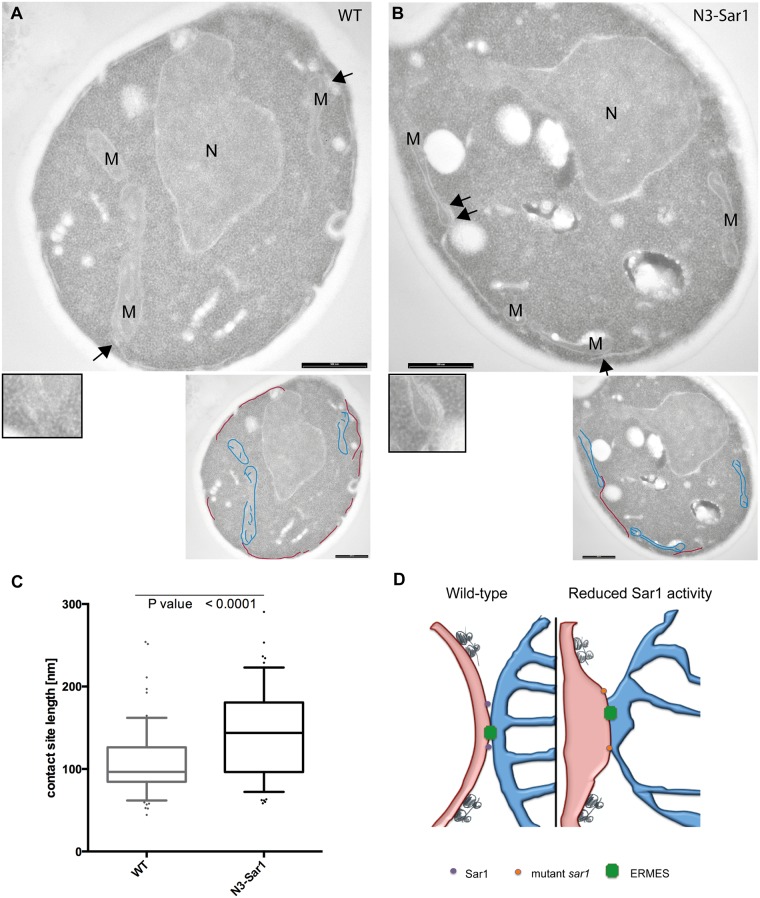
The N3-Sar1 mutant increases ER-mitochondria contacts site length.Transmission electron microscopy images of (A) wild type and (B) N3-sar1. The bars in (A) and (B) correspond to 1 μm. N: nucleus; M: mitochondria. Arrows point to regions of ER-mitochondria contacts. The insets display a 2x magnification of a region of interest. Relevant ER membranes and mitochondria were traced in red and blue, respectively, in the smaller images. (C) Quantification of the phenotype presented in (A) and (B). > 60 contacts were measured/genotype from two independent embeddings. An unpaired, two tailed T-test was used for statistical analysis. The whiskers represent 10–90% of the data. The line in the box indicates the mean. (D) Model on Sar1 function at ER-mitochondrial contact sites. For explanation see text.